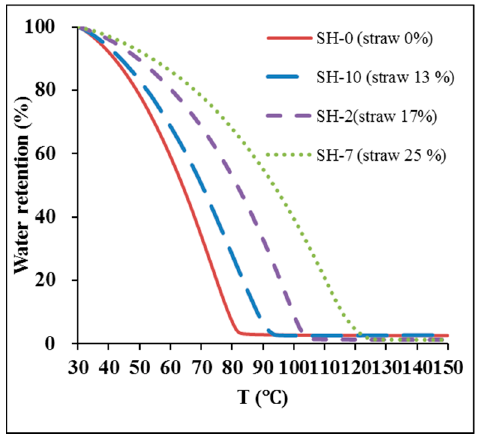
Figure 9. Water retention curve of hydrogels.